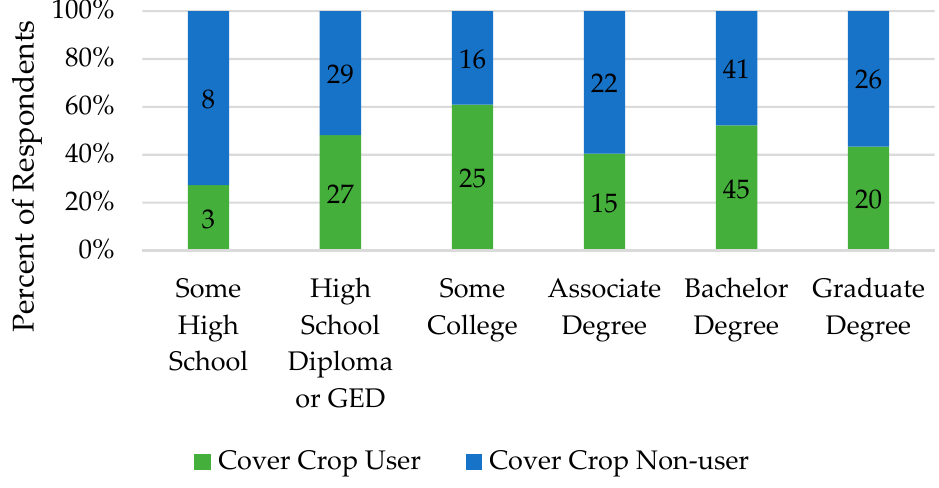
Figure 6. The distribution of respondents based on age ( p < 0.05).